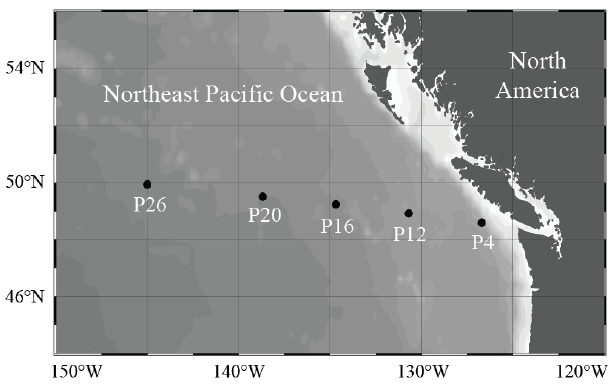
Figure 1. Map showing the Line P stations sampled in this study.